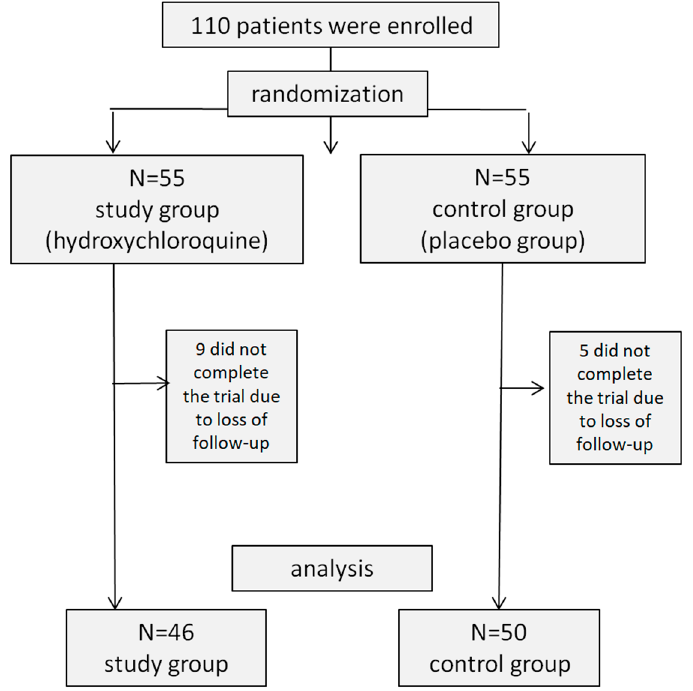
Figure 3. Flow Diagram of the study’s participants. Of the 110 patients who enrolled in the study, 55 were randomized to the study group, and 55 to the control group. Fourteen patients did not complete the trial due to loss of follow-up. Forty-six patients in the study group and fifty in the control group completed the study. Table 1. Demographic characteristics and baseline ocular characteristics of the study (hy- droxychloroquine) and control (placebo) groups.